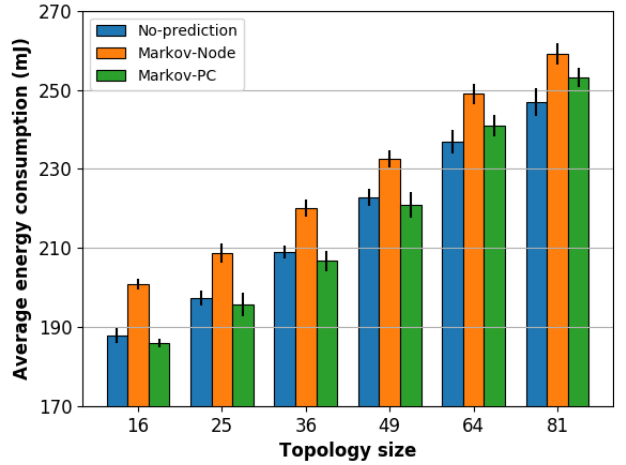
Figure 5. Energy consumption of No-Prediction and Markov chain schemes: values in milijoules.